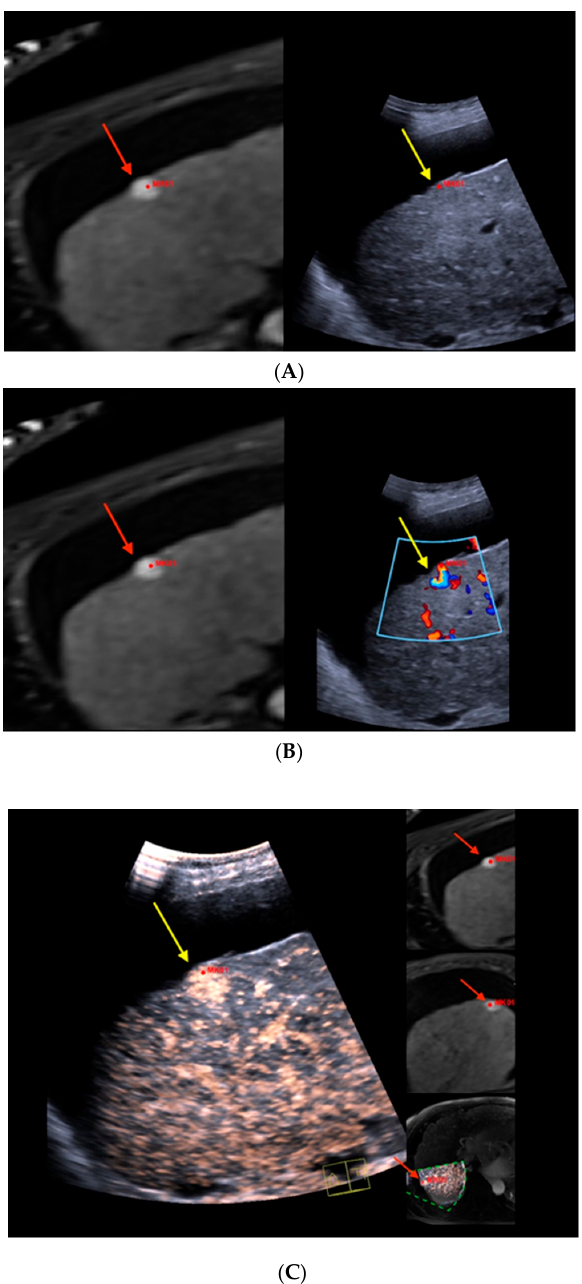
Figure 1. Real-time magnetic resonance imaging-/contrast-enhanced ultrasound (MRI-/CEUS)-fusion imaging of a hypervascularized focal liver lesion in a cirrhotic patient. ( A ) A hypervascularized subcapsular focal lesion in liver segment 7 was registered in MRI, arterial phase (left), a target lesion (MK01, red) was placed for precise correlation with native B-mode (right) in a side-by-side manner. The focal lesion otherwise was barely detectable by conventional ultrasound. ( B ) Additional Color Doppler showed livid hypervascularization of the lesion (right), a corresponding plane of MRI, arterial phase (left). ( C ) Peripheral-to-central contrast-enhancement and, finally, homogeneous contrast enhancement was registered in CEUS (left, maximized), implicating focal nodular hyperplasia. The software interface of the ultrasound device showed four different images: real-time CEUS images (left, maximized), MRI datasets in axial (upper right) and sagittal (middle right) reformation, and a real-time 3D navigation of the MRI-/CEUS-fusion imaging (lower right), (lesion marked by red arrows).